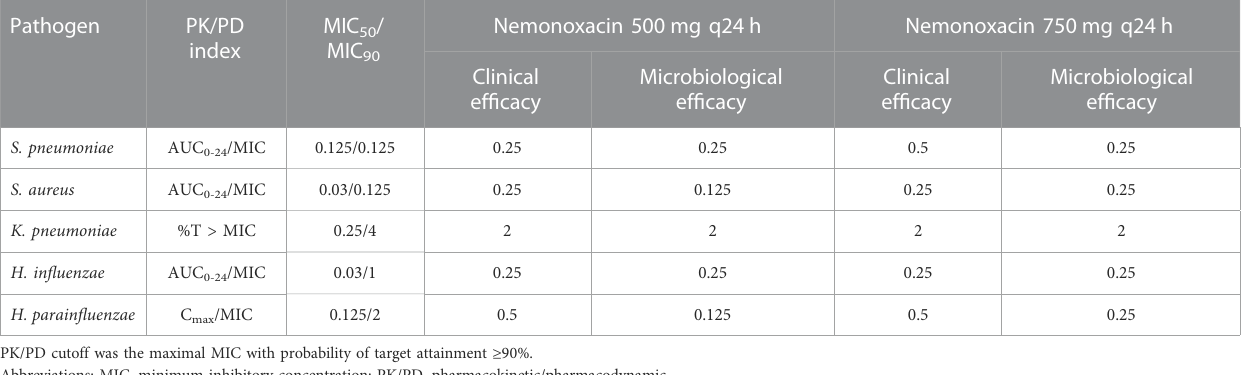
TABLE 4 PK/PD cutoff values of nemonoxacin (mg/L). Pathogen